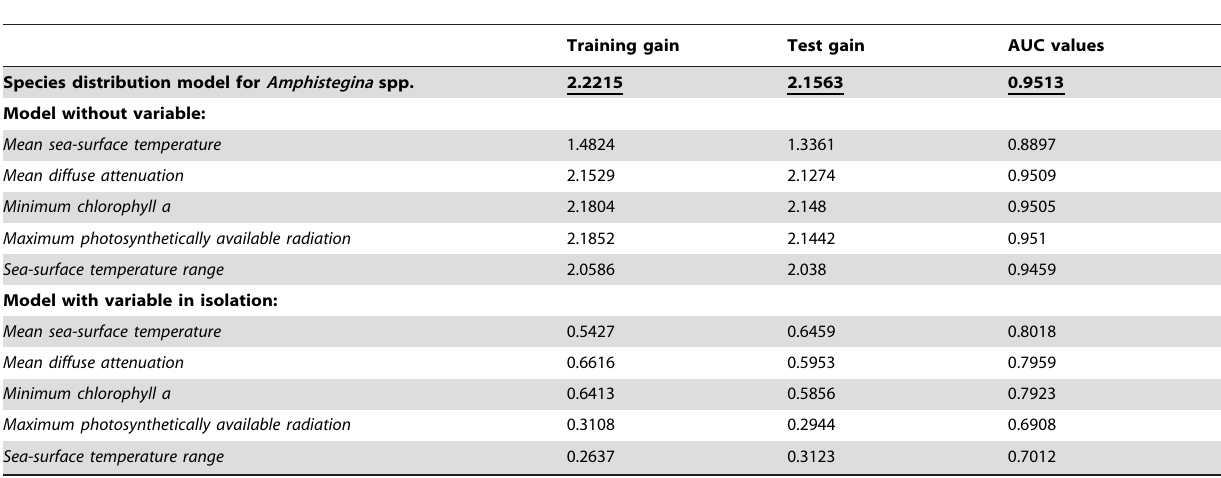
Table 2 Results of the Jackknife test for training and test